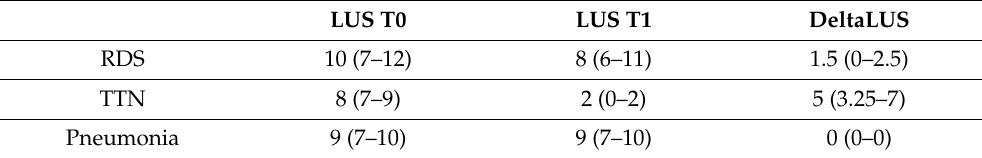
Table 4. nLUS and